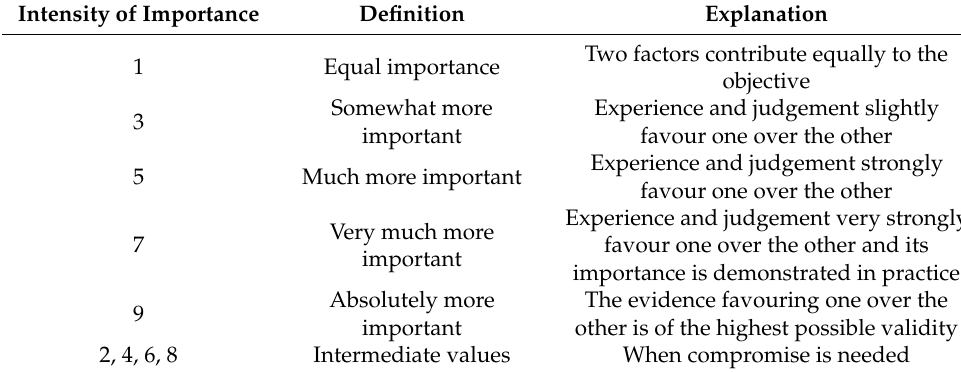
Table 2. Saaty’s rating